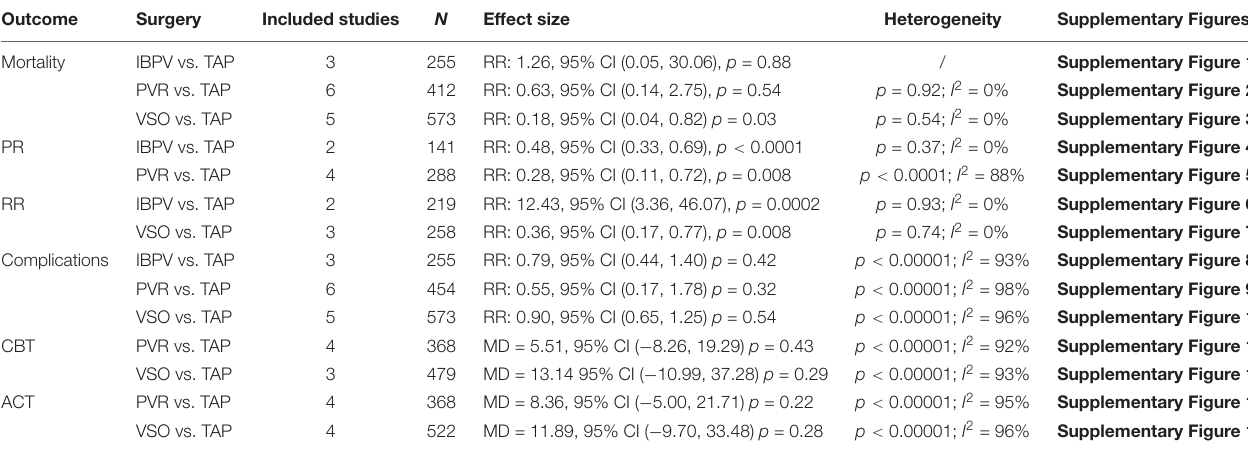
TABLE 2 | Summary of forest plot in the